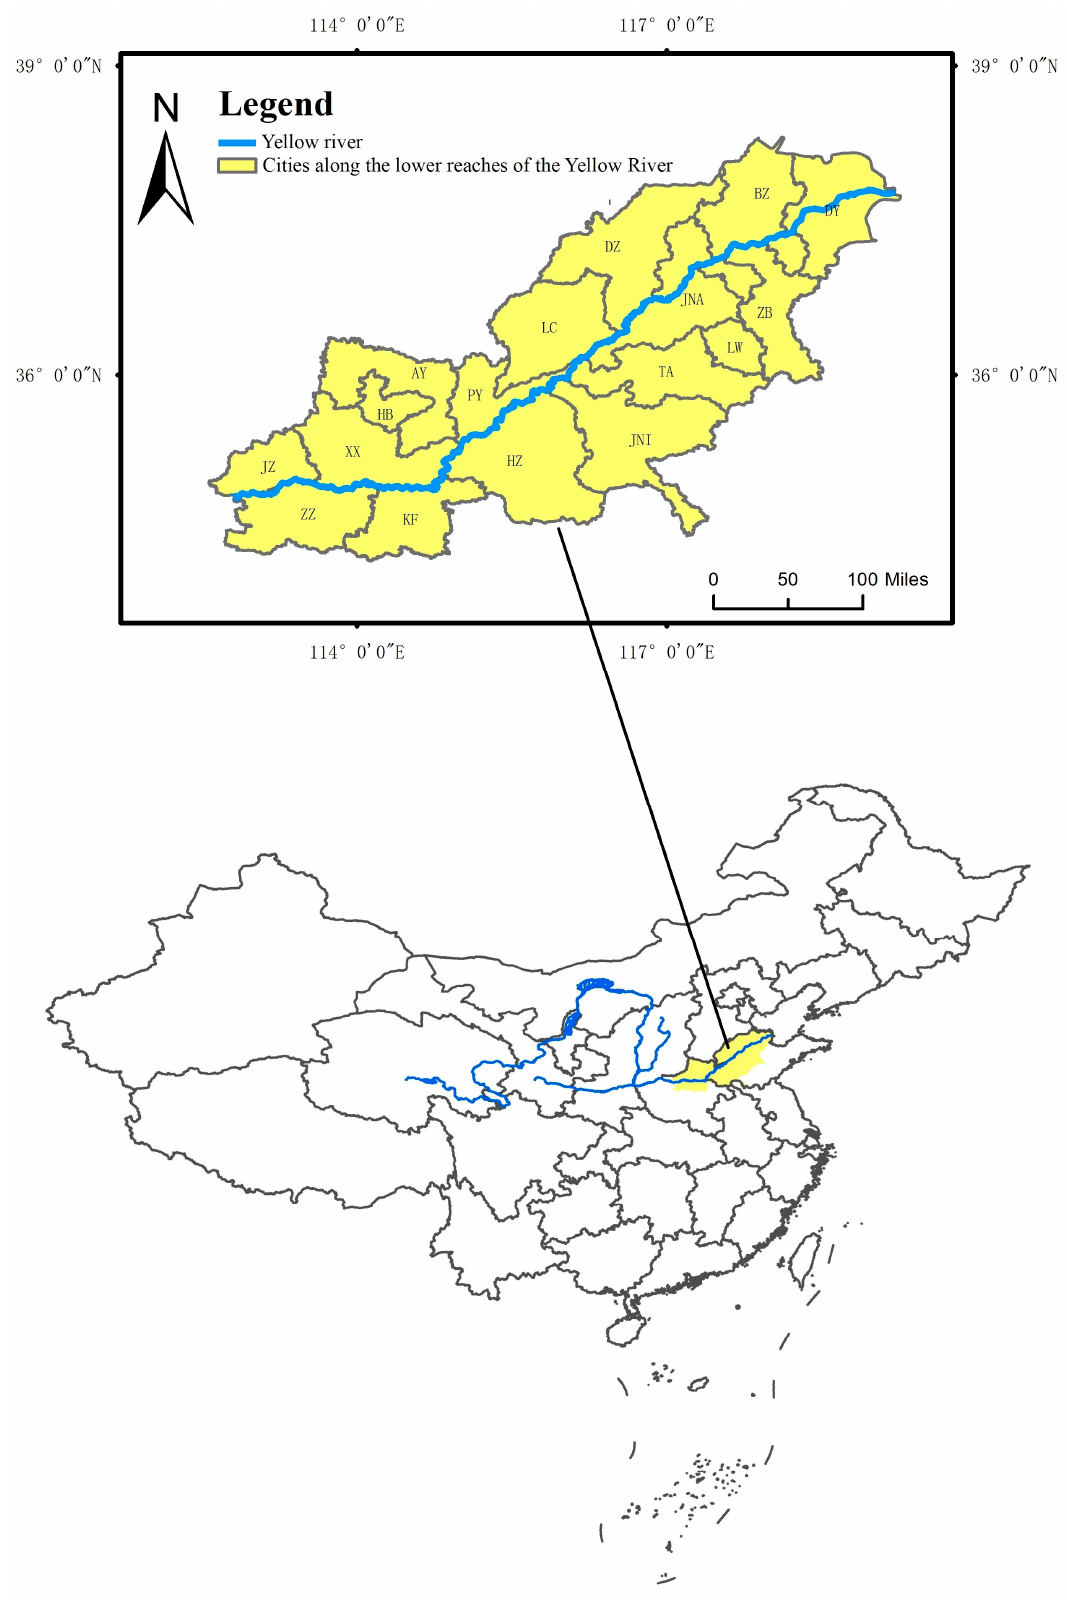
Figure 1. City group map along the lower reaches of the Yellow River.